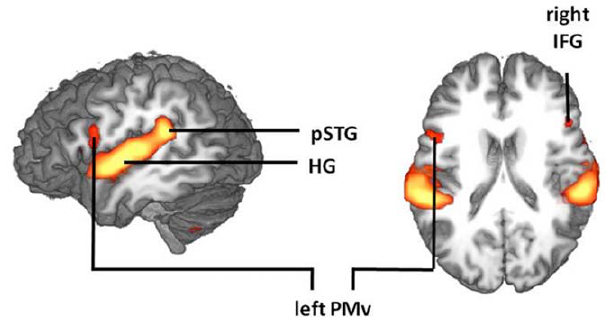
Figure 4. Synchronization (SC) versus self-paced control condition (CC). A conjunction of all four independent scans revealed activity increase in the bilateral Heschl’s gyrus, the left posterior superior temporal gyrus and the left PMv for auditory-motor timing (SC vs. CC); corrected at p , .005, displayed at p , .001 for illustration